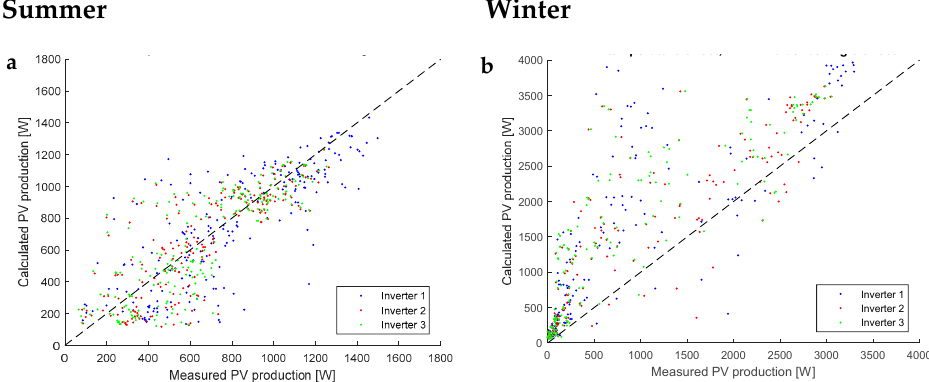
Figure 7. Comparison between the calculated and measured PV production by the inverter, for June ( a ) and November ( b ) 2012. Table 2. Normalized mean bias error (nMBE), normalized mean absolute error (nMAE), and normalized root mean squared error (nRMSE) by inverter, for June and November 2012. Month